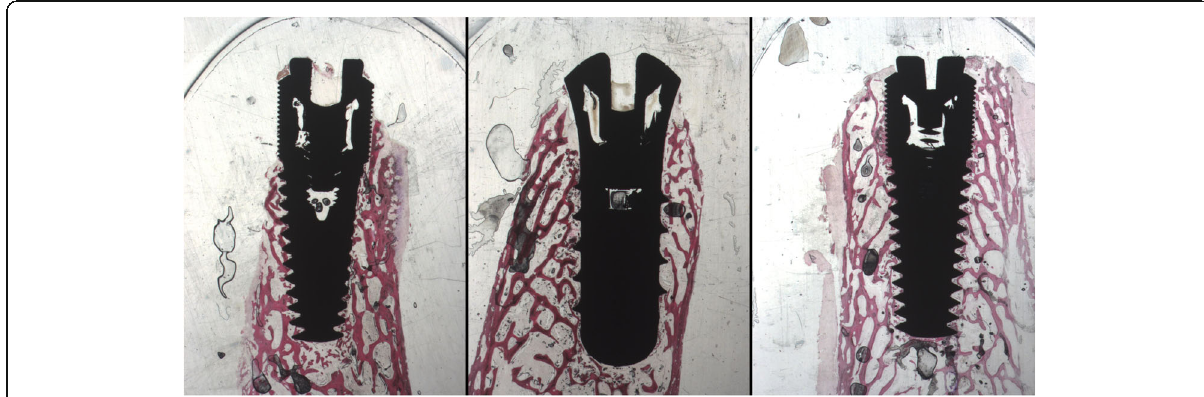
Fig. 5 Optic microscope photo (× 9 magnification) after 15 days of implantation. Left side: machined implant (group C). Central photo: sandblasted and acid-etched implant (group A). Right side: laser-treated